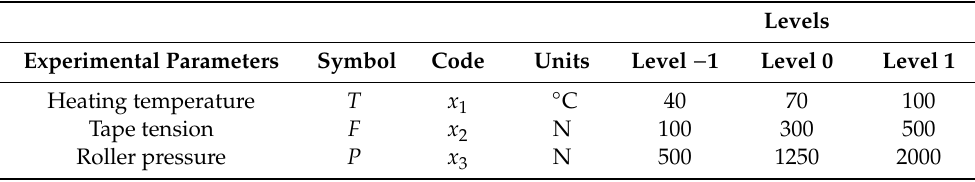
Table 1. The experiments were performed 17 times based on di ff erent parameters’ combinations. Table 1. Level of process parameters.